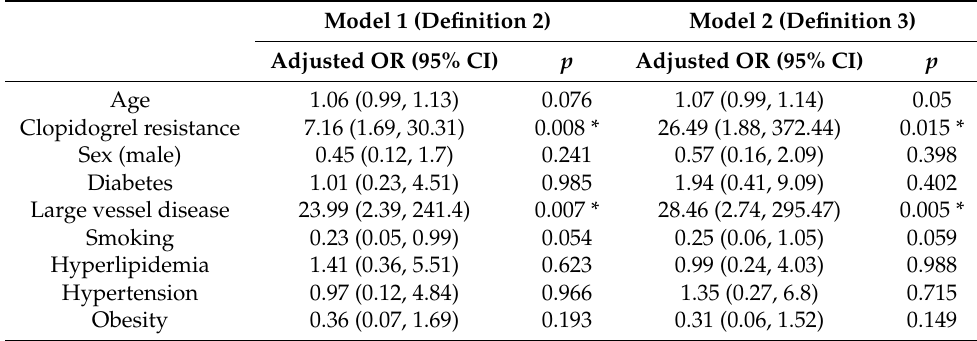
Table 3. Multivariate logistic regression analysis of predictors of a significant size of acute ischemic infarct in two models, depending on the definition of the